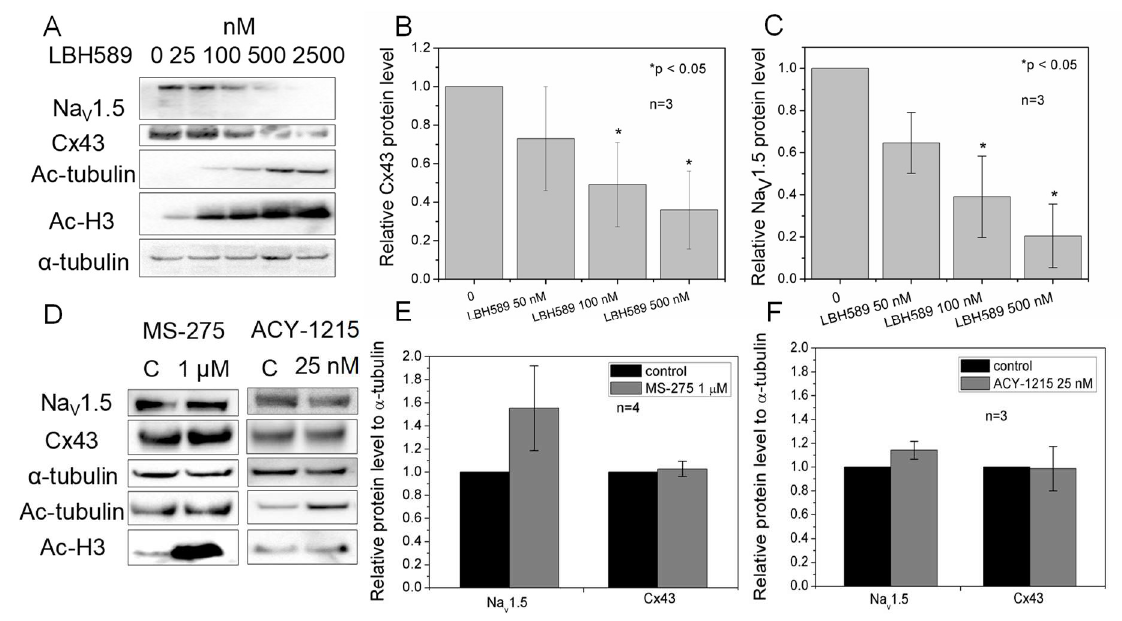
Figure 6. Changes in cardiac Cx43 and Na V 1.5 protein levels by panobinostat, entinostat and ricolinostat. ( A ) Representative Western blot of lysed NMVMs treated with 0, 25, 100, 500, and 2500 nM panobinostat for 24 h. Ac-tubulin is acetylated α -tubulin, Ac-H3 is acetylated histone 3, and α -tubulin was used as a loading control. ( B ) Densitometry scans of Cx43 Western blots ( n = 3) to quantify the reduction in Cx43 protein levels with increasing concentrations of panobinostat (* p < 0.05). ( C ) Densitometry scans of Na V 1.5 Western blots ( n = 3) quantifying the statistically significant decrease in Na V 1.5 protein levels with higher concentrations of panobinostat (* p < 0.05). ( D ) A representative Western blot of lysed ventricular myocytes treated with 1 µ M entinostat (MS-275) or 25 nM ricolinostat for 24 h. Note that MS-275 only increased the Ac-H3 signal while ACY-1215 only increased the Ac- α -tubulin signal, consistent with their class I and HDAC6 inhibitory activities. ( E ) Densitometry scans of 1 µ M entinostat Western blots ( n = 4) illustrating no significant changes in Cx43 or Na V 1.5 protein levels with entinostat, a class I HDAC-selective inhibitor. ( F ) Densitometry scans of 25 nM ricolinostat Western blots ( n = 3) illustrating no significant changes in Cx43 or Na V 1.5 protein levels with ricolinostat.